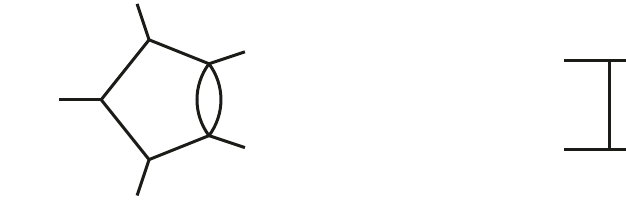
Figure 2 . Planar two-loop (cid:12)ve-point